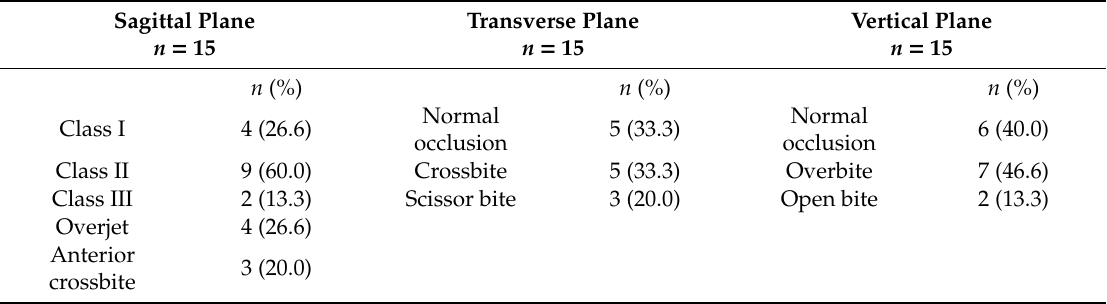
Table 5. Intermaxillary relationships and tooth malocclusions in patients with Wolf-Hirschhorn syndrome. Sagittal